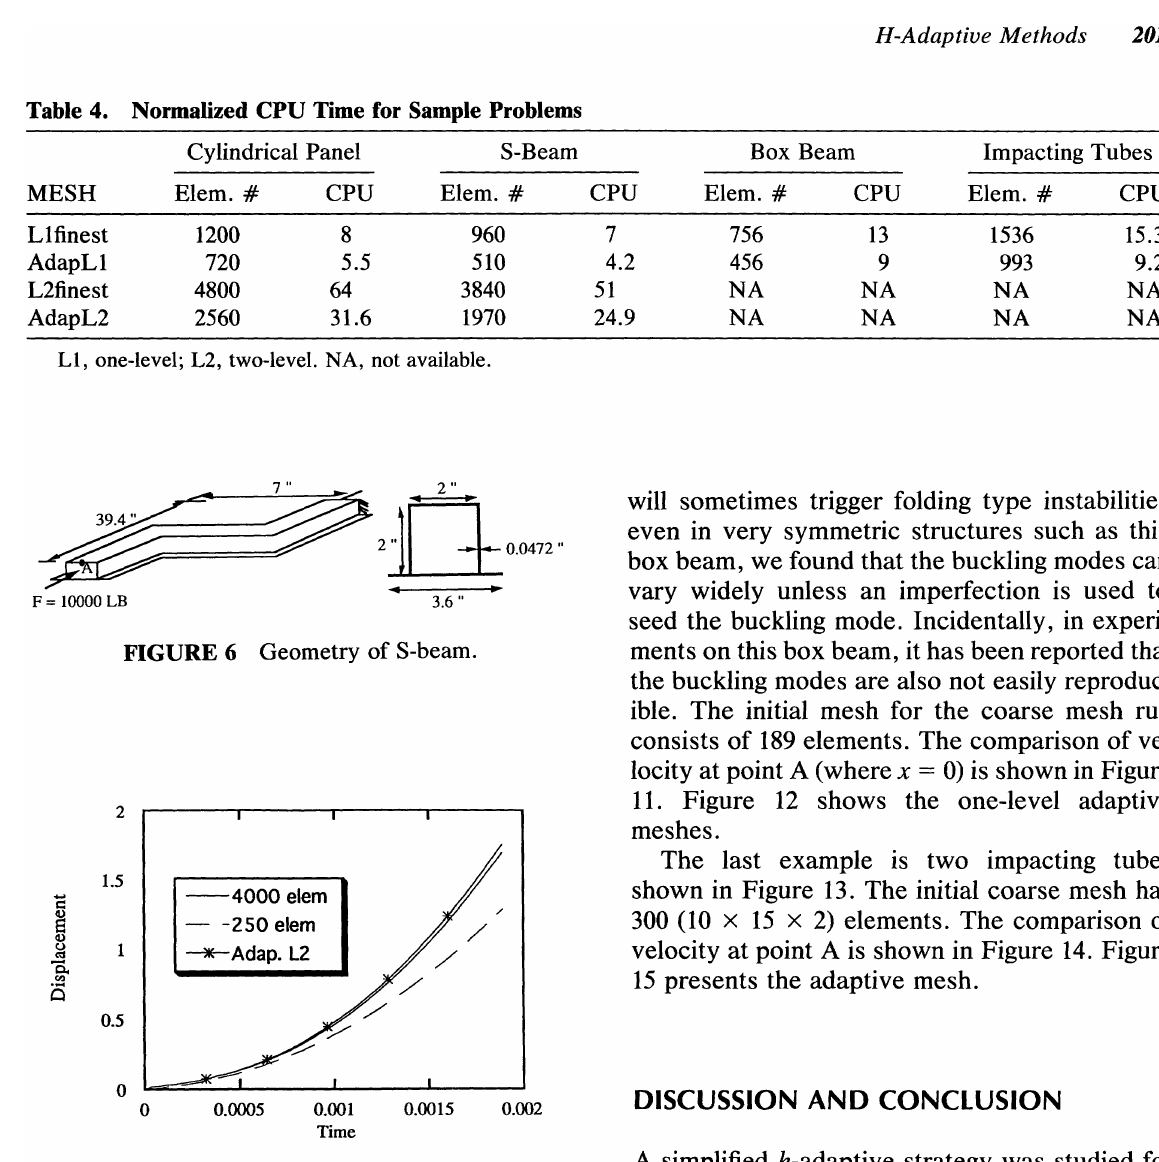
FIGURE 7 Axial displacement of point A in S-beam.